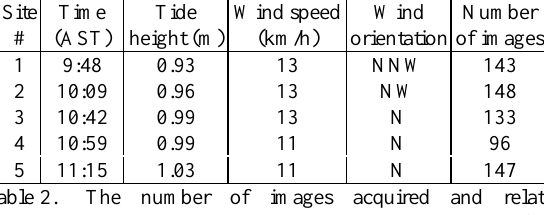
Figure 2. RGB composite for the mosaic created using Pix4D with the images acquired over Shediac Bay on August 31st,